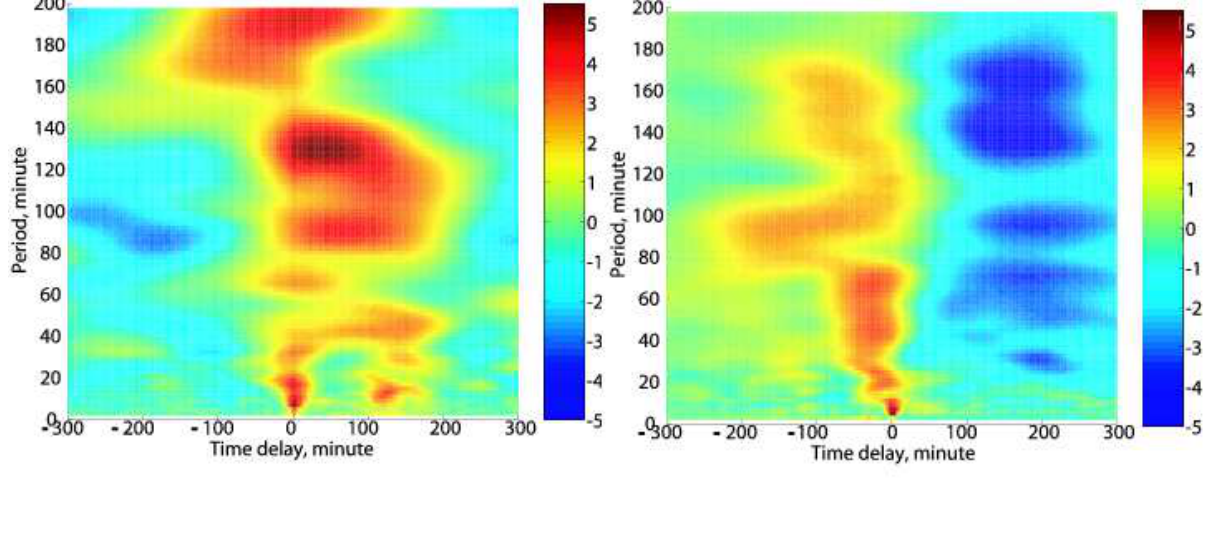
Figure 8. The superimposed epoch analysis for the cross-correlation of fluctuation at the two stations of Chiba and Kochi. The left panel refers to the period before the earthquake (December 16 to December 26, 2004), while the right, a quite period after the earthquake (May 2 to May 12, 2005). The time delay at CBA on the abscissa is defined with respect to KOC (the delay of +2 hours in the